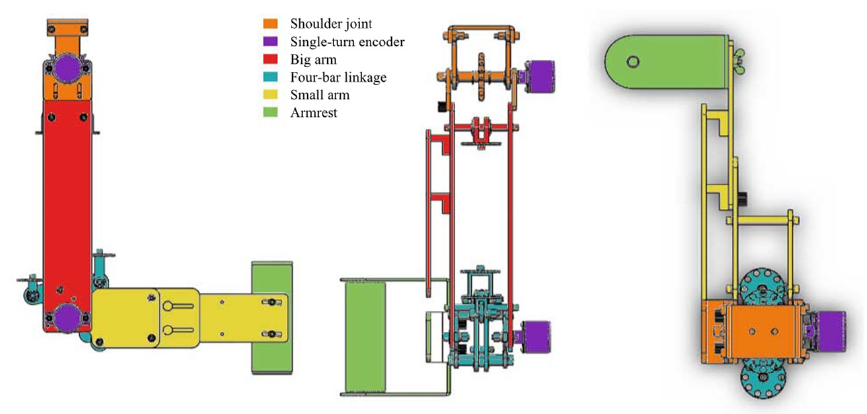
Figure 1. Three view drawing of rehabilitation robot.